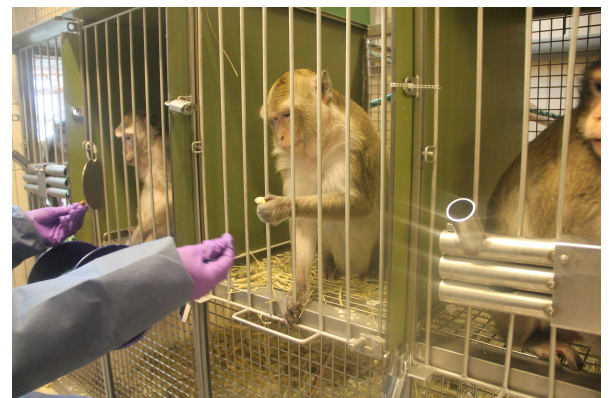
Figure 4. Visual barriers may separate a group of animals during training sessions. Here, the animals are in a training tunnel adjacent to their indoor/outdoor cages and may leave their training positions at any time. Image courtesy of Astrid Fagraeus